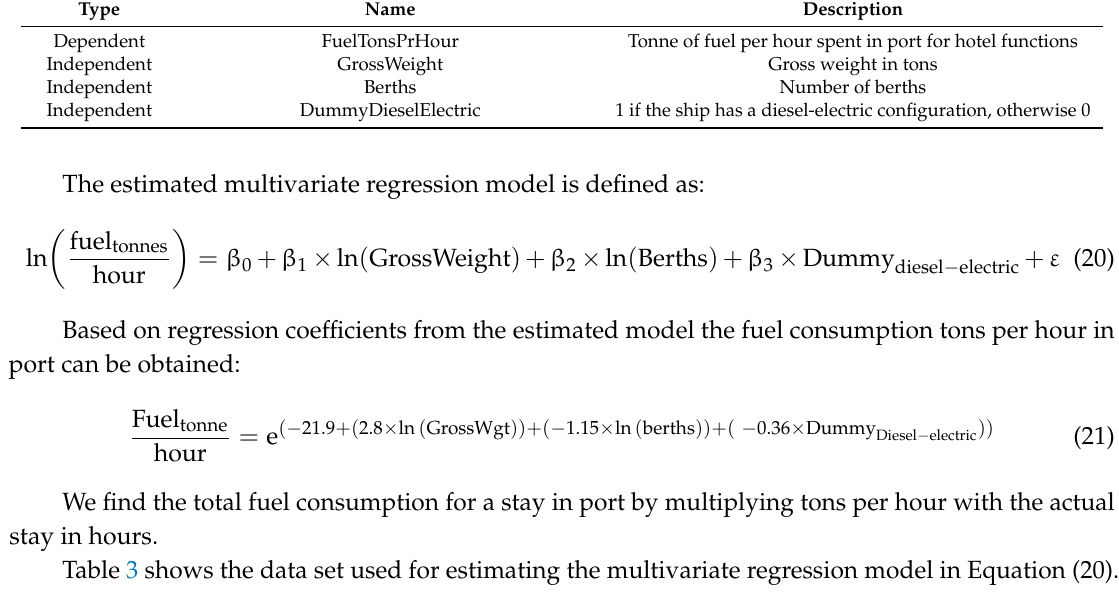
Table 3. Data for fuel consumption in port from